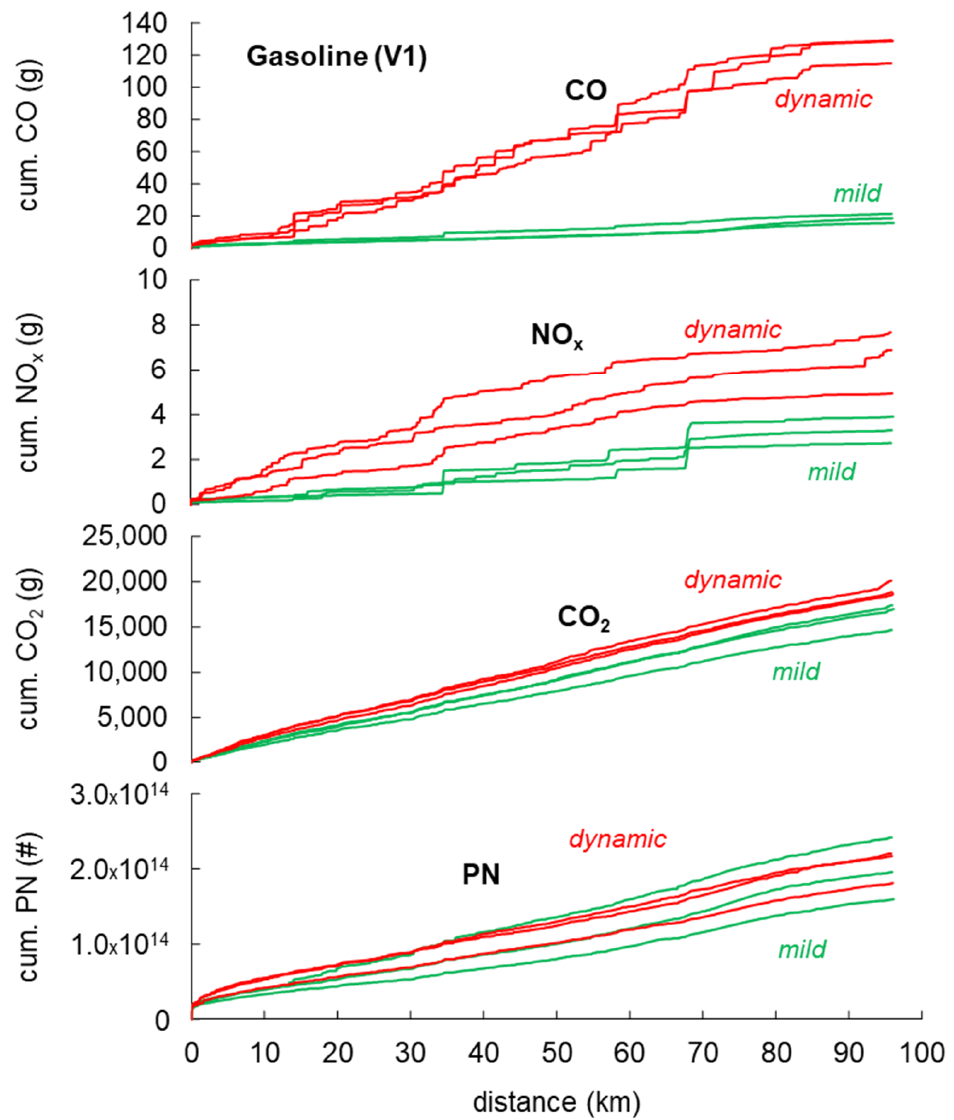
Figure 7. Influences of the driving style on the cumulated emissions of the gasoline vehicle (V1).